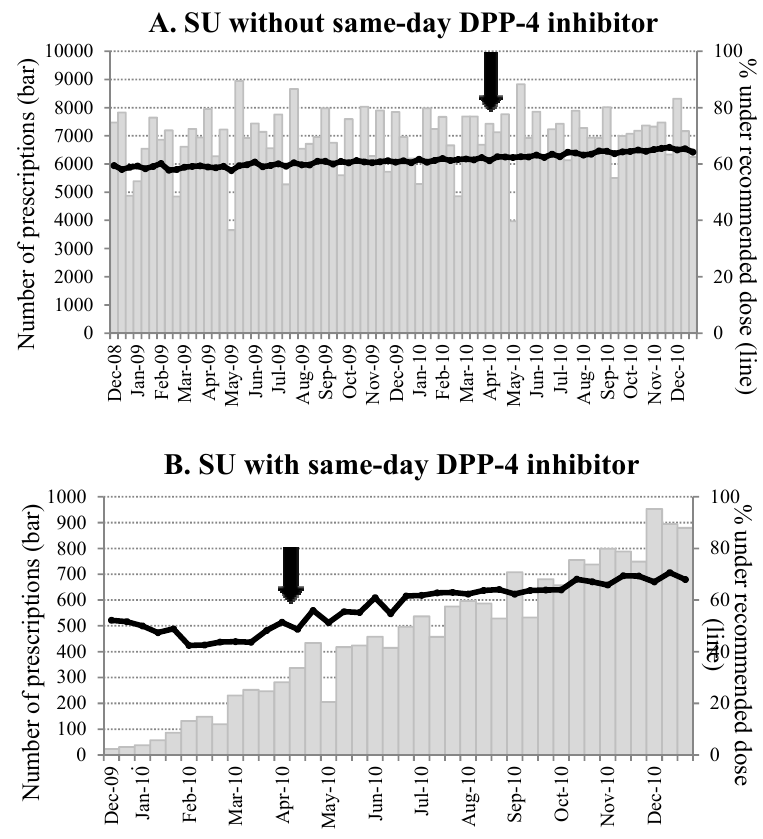
Figure 1. Chronological trend in number of SU prescription (bars) and proportion to SU prescriptions under the recommended dose (lines). ( A ) SU prescriptions without DPP-4 inhibitor; ( B ) SU prescriptions with DPP-4 inhibitor. Data is summarized for every 10 days (1st to 10th, 11th to 20th, and 21t to the end of the month for each month). The arrows indicate the timing of the recommendation